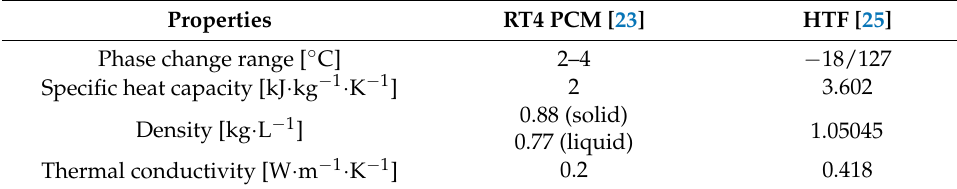
Table 2. Properties of the PCM and the